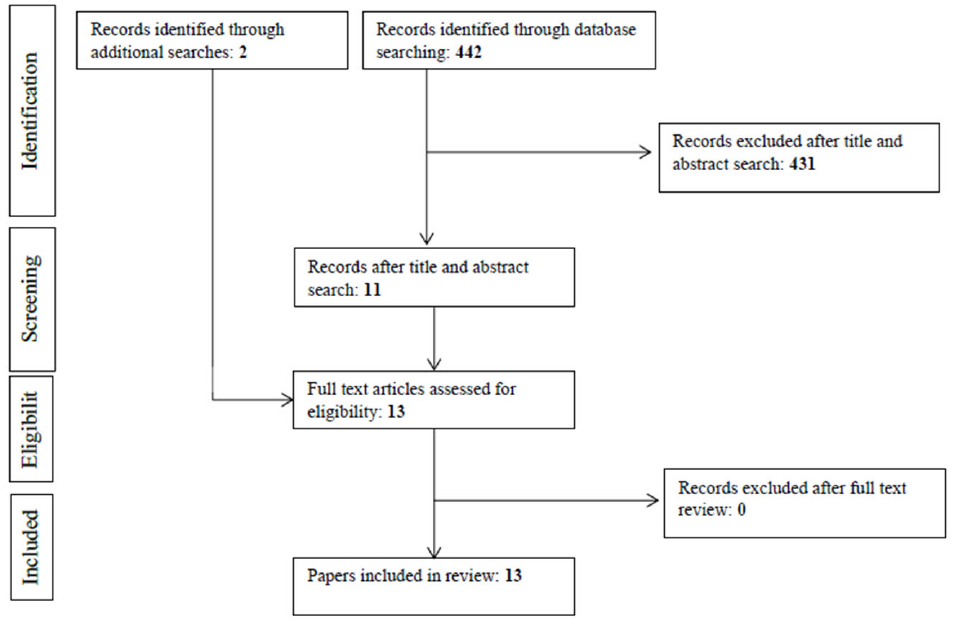
Figure 2. PRISMA flow diagram of included studies.